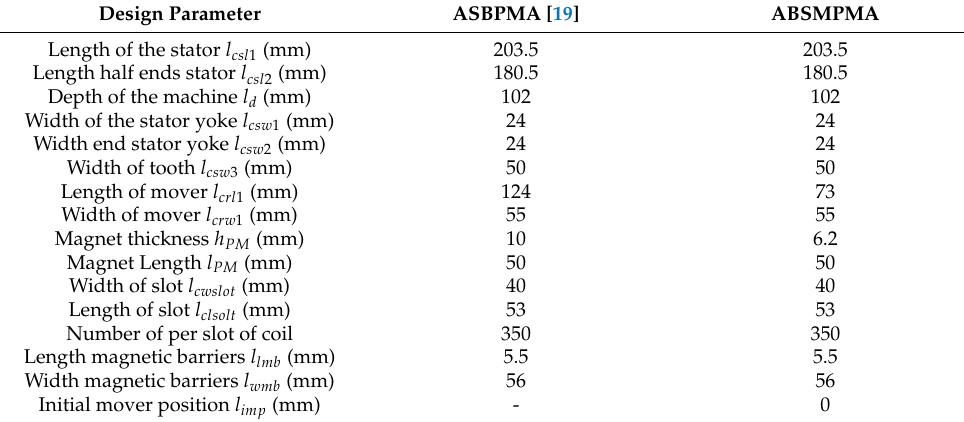
Table 2. Parameters of machine.